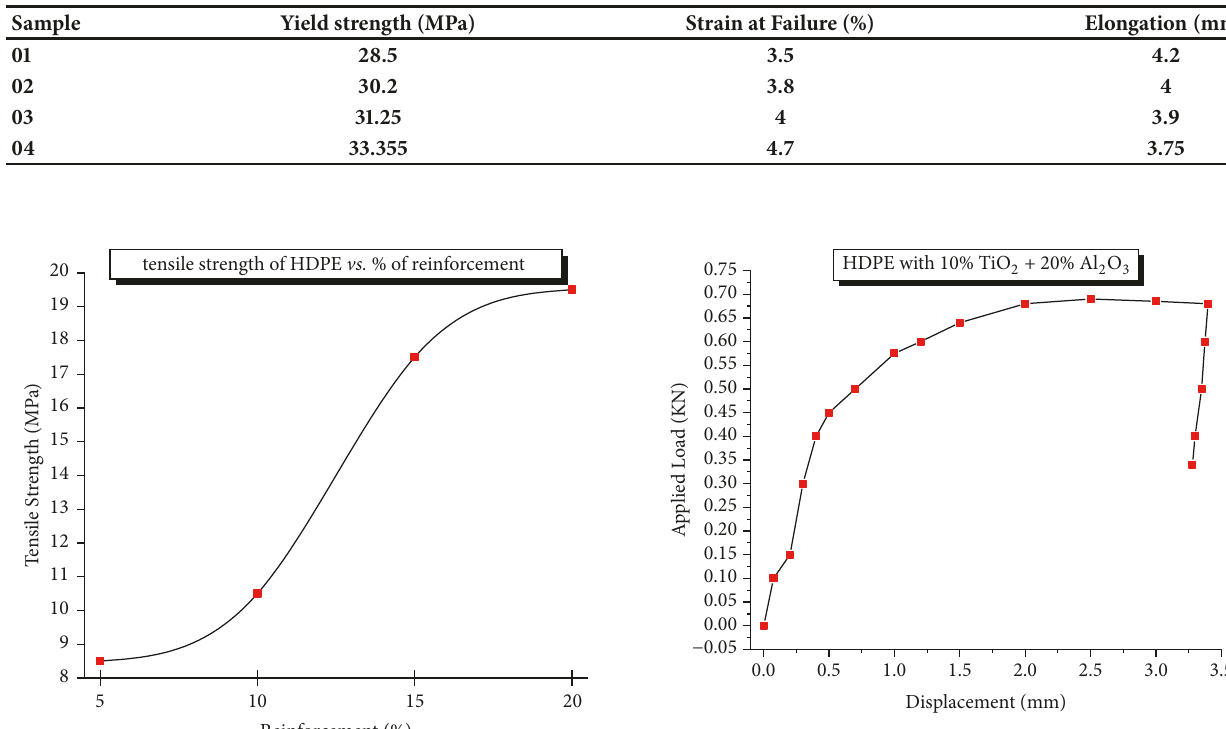
Figure3:AppliedloadversusdisplacementcurveofHPMC(sample 4).